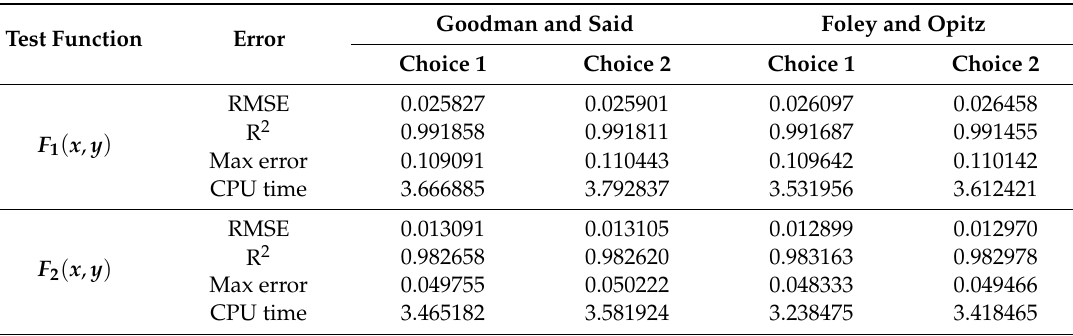
Table 5. Error analysis for 36 datasets.